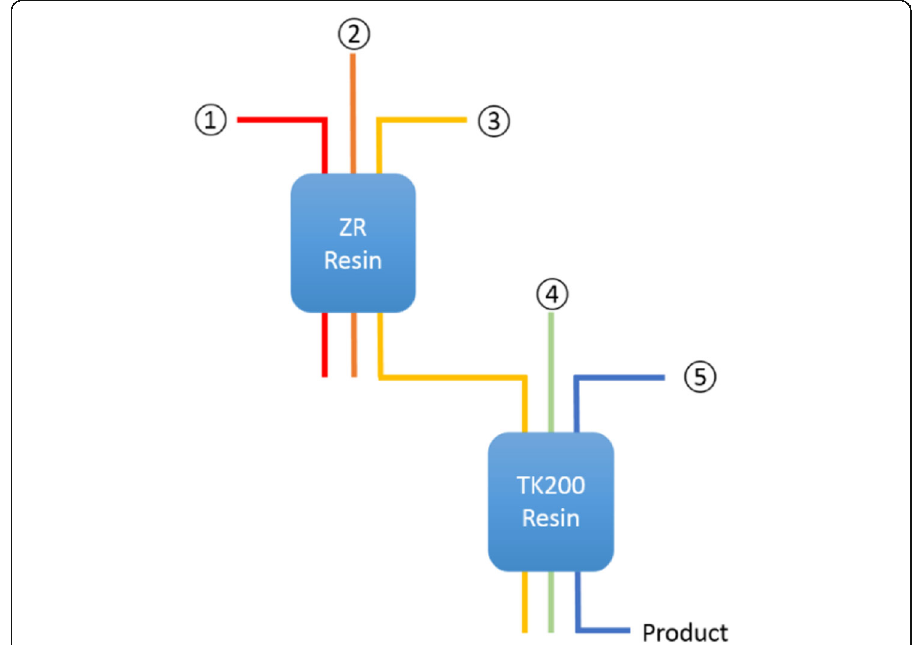
Fig. 4 Two-column approach for 68 Ga chemical